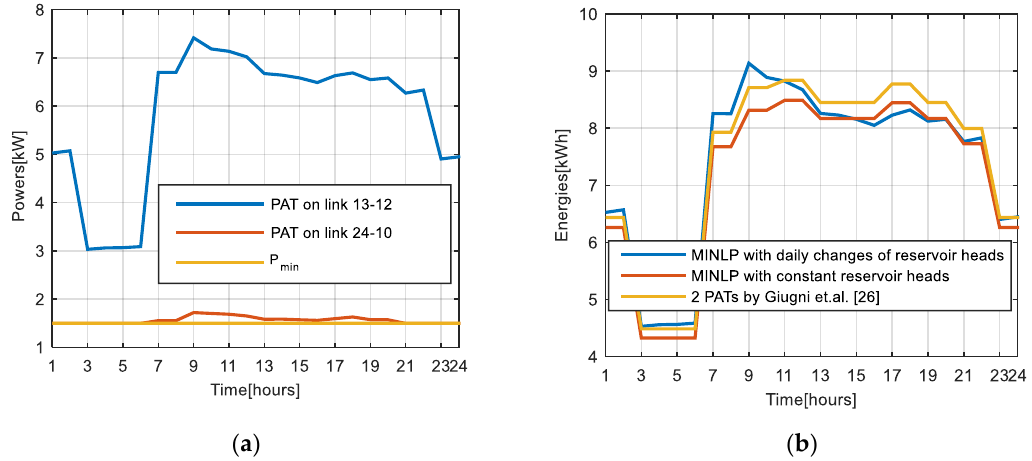
Figure 6. ( a ) Power generation profiles by varying reservoir water levels; ( b ) Comparisons by constant reservoir water levels.